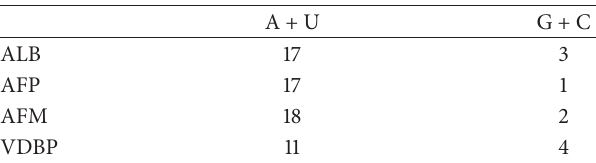
Table 4: A + U and G + C preferential codon usage of human albumin superfamily